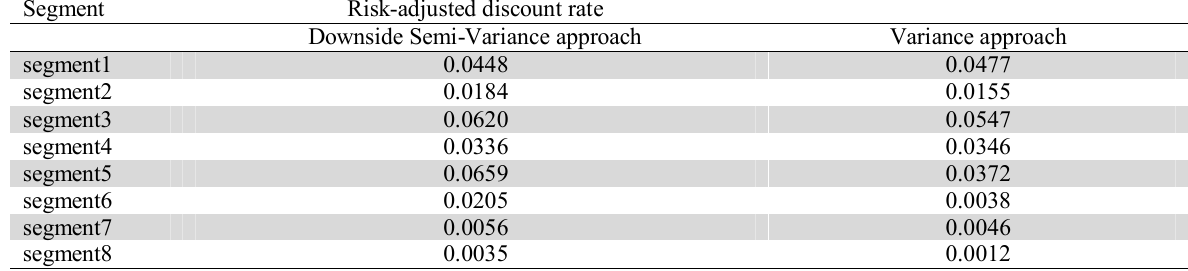
Risk-Adjusted discount rate for different customer segments via different approaches of risk measurement Risk-adjusted discount rate